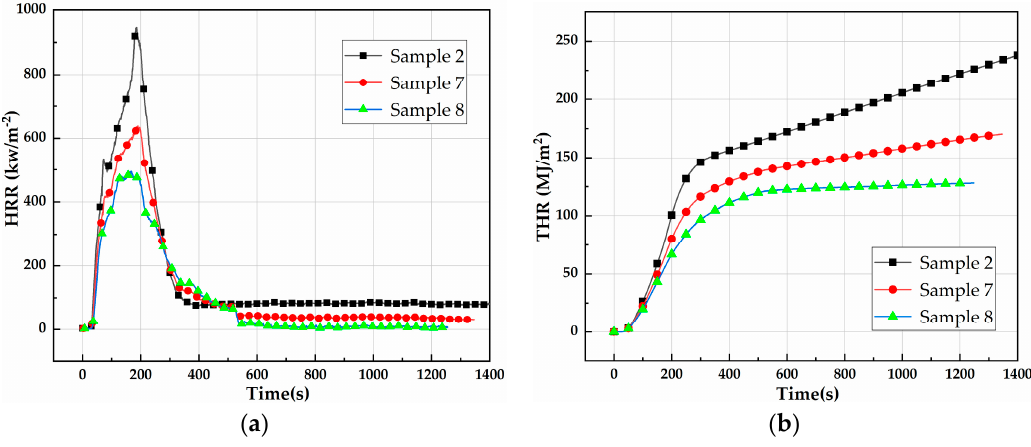
Figure 4. HRR ( a ) and THR ( b ) curves for asphalt binder.